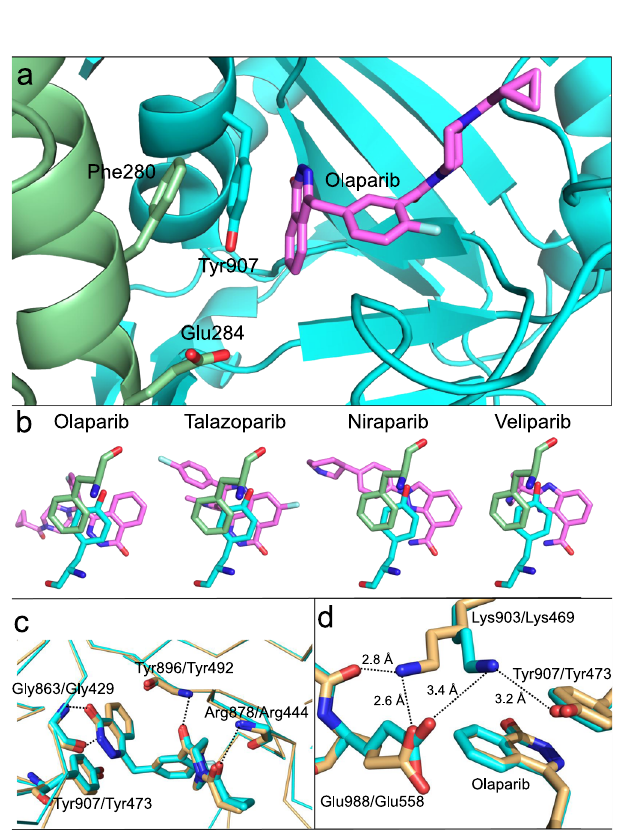
Fig. 5 Docking models of the PARP1 – HPF1 – PARPi complexes. a Model of the PARP1 active site (in cyan) bound to olaparib (in violet) and docked to HPF1 (in green) showing the pi-pi-pi stack that may explain the increased af fi nity of olaparib for PARP1 in the presence of HPF1. The catalytic base of HPF1 (Glu284) is the closest residue to olaparib but makes no direct contacts (>6 Å). b Olaparib and talazoparib both have pi-pi-pi stacks between Phe280 of HPF1 (in green), Tyr907 of PARP1 (in cyan), and the PARPi (in violet), whereas for niraparib and veliparib this stacking interaction is not as well aligned due to differences in the ring systems. c Overlay of the structures of PARP1 (pdb id = 5ds3) and PARP2 (pdb id = 4tvj) both with bound olaparib demonstrating the nearly identical interactions of all active site residues that make direct contact with the inhibitor. The H-bonds shown are all with backbone atoms and the pi- stacking tyrosine is also shown. The backbone trace is shown to emphasize the overall similarity in the catalytic domains (RMSD = 0.55 Å). affects the inhibition by olaparib of PARP1 (in cyan) but not PARP2 (in light